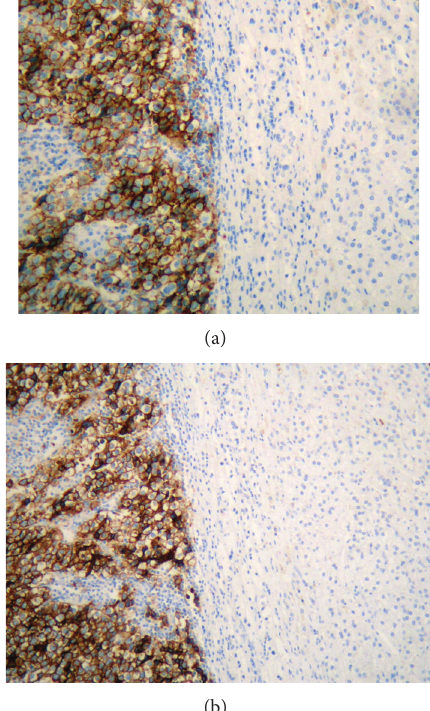
Figure 3: Seminoma cells markers expression (a) CD 117 and (b)